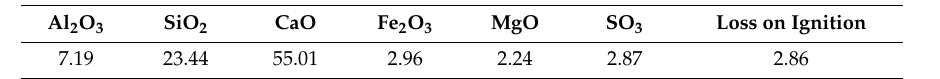
Table 2. Chemical composition of PO 42.5 R cement (%).